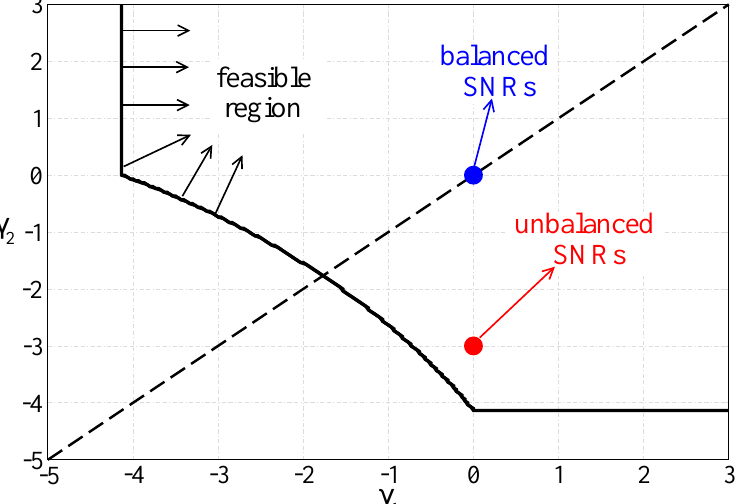
Figure 2. Feasible region in a scenario with two sources and ρ = 0 . 95